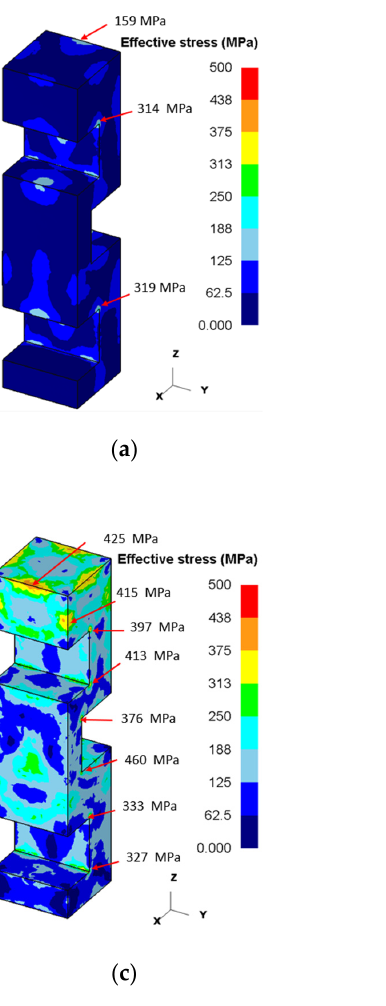
Figure 15. Final stress profiles after quench: ( a ) vertical oil quench; ( b ) horizontal oil quench; ( c ) vertical water quench; and ( d ) horizontal water quench.